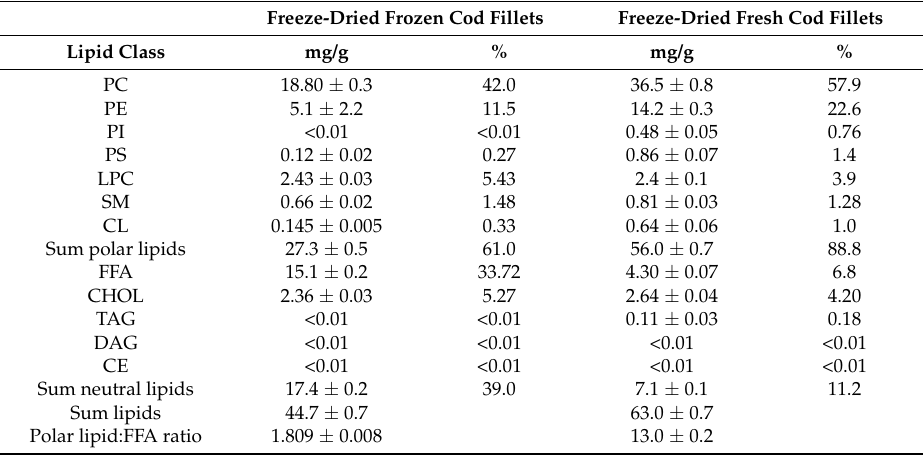
Table 1. Lipid class composition in freeze-dried fresh and frozen cod fillets.